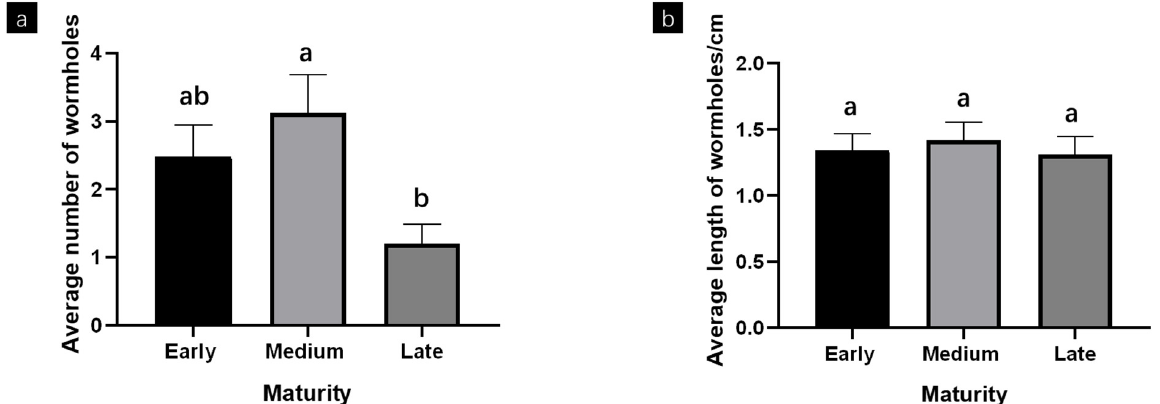
Figure 2. The average wormhole number and length in pods of three maturity types. ( a ) The average wormhole number in pods of three maturity types; ( b ) The average wormhole length in pods of three maturity types. Error line represents standard error. The same lowercase letter means no significant difference.